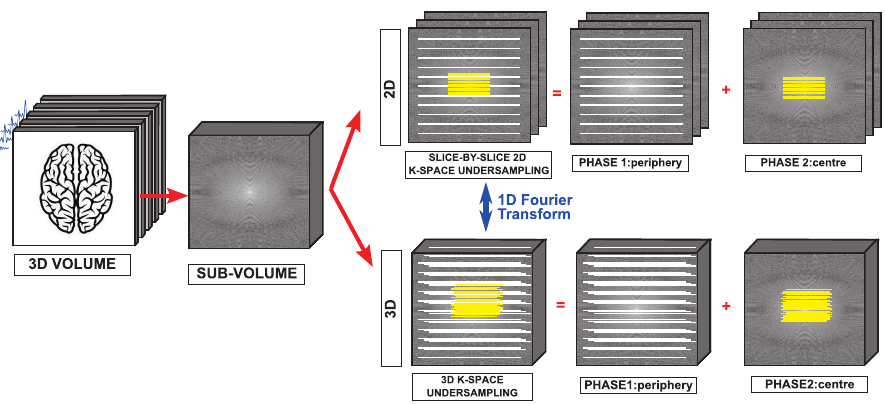
Figure 4. Illustration of the acquisition of the 3D volume containing the brain. Each sub-volume is acquired considering a 3D two-phase EPI scheme (bottom line). The presented results were obtained considering a sequence of identical slice-by-slice 2D k-space under-sampling schemes (top line), which can be brought back to a specific class of 3D k-space under-sampling scheme to which a Fourier transform in the third dimension was applied. The proposed pattern results from the combination of two different regular schemes: the fully sampled central zone (yellow lines) and the regularly under-sampled periphery (white